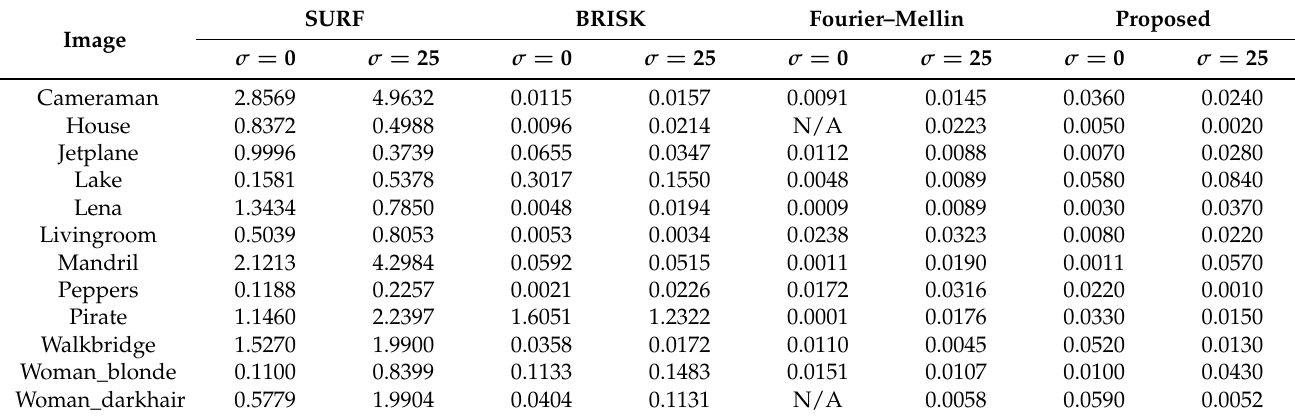
Table 2. Comparison of fixed degree estimation errors; the rotation angle is 120 ◦